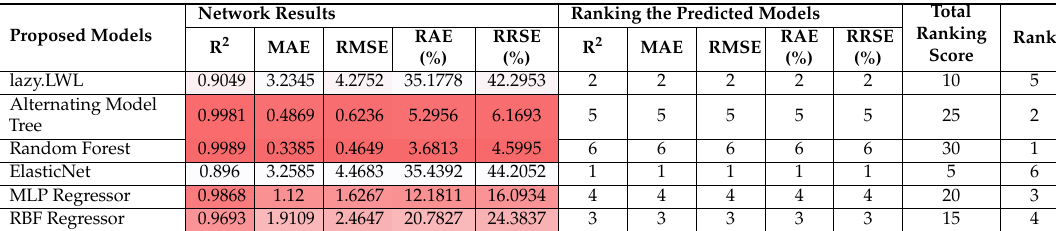
Table 4. The performance of selected machine learning techniques in the prediction of heating load through several statistical indexes (testing dataset).